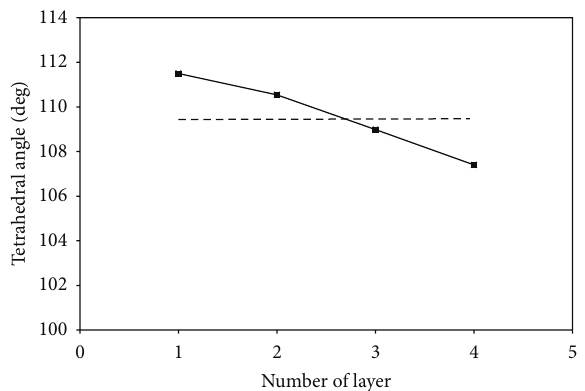
Figure 6: Tetrahedral angle as a function of number of layers for InSb-hexamantane. PBE/3-21G method is used for the calculations of this figure. The dashed line represents the ideal experimental bulk value of tetrahedral angle at 109.47 [18].